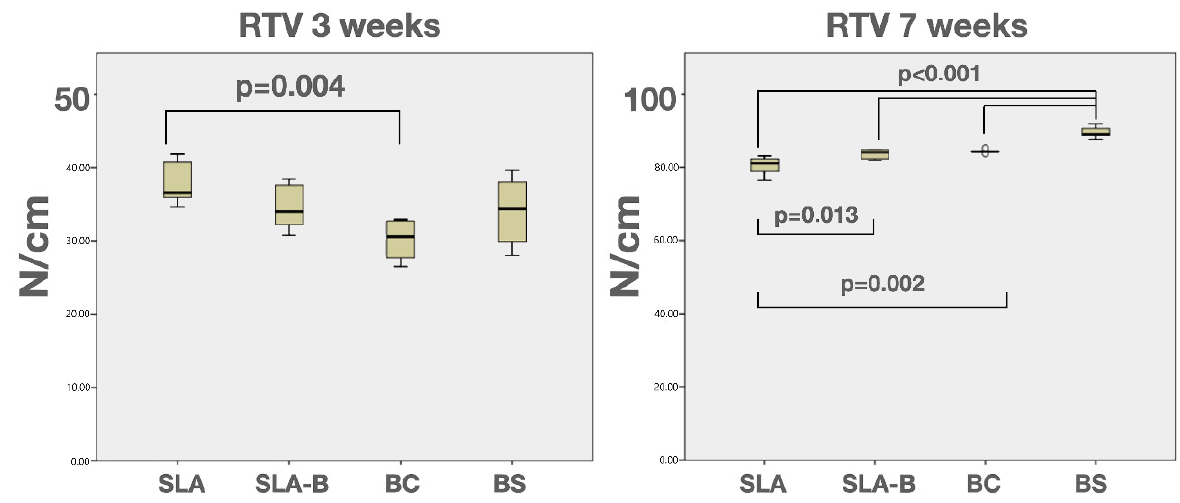
Figure 10. Box-and-whisker plots showing median and quartile values for the removal torque test (RTV) measurements.